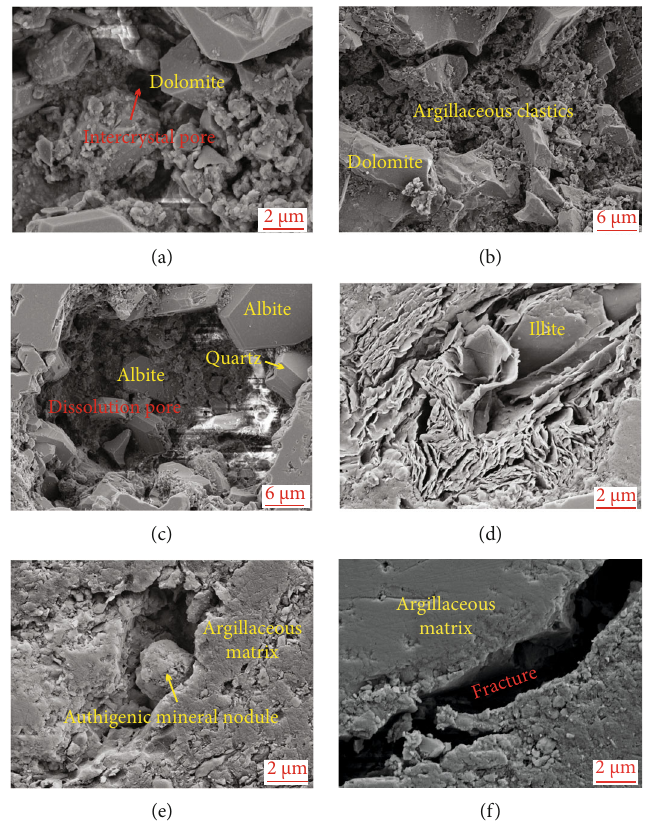
Figure 7: FE-SEM images showing the reservoir space types in the Lucaogou Formation, Jimusar Sag: (a) well J303, 2597.7m, dolomite with intercrystalline pores; (b) well J305, 3416.8m, dolomitic mudstone with intergranular pores and dissolution pores; (c) well J10025, 3549.43m, silty mudstone with dissolution pores; (d) well J43, 2948.5m, shale with intercrystalline pores between clay minerals (illite); (e) well J10025, 3567.6m, shale with intergranular pores and dissolution pores and authigenic mineral nodules; (f) well J303, 2597.7 m, dolomite with